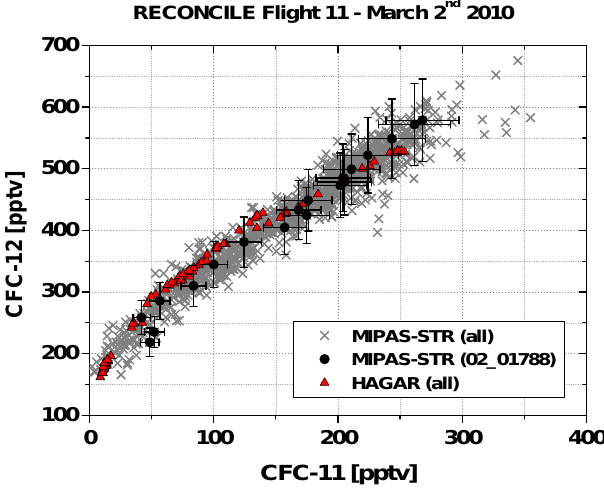
Fig. 17. Correlation of CFC-11 and CFC-12 derived from the MIPAS-STR and HAGAR measurements for RECONCILE flight 11. For MIPAS-STR, all retrieved profile points with a vertical reso- lution better than 5km are shown. The points associated to sequence 02 01788 of MIPAS-STR, for which the in-situ profile-comparisons are carried out, are shown together with the corresponding esti- mated 1 σ -errors.